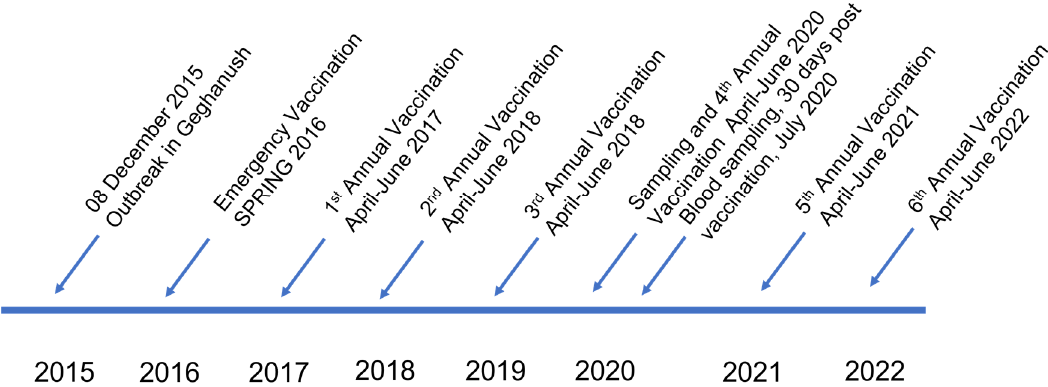
Figure 1. Outbreak on 8 December 2015 in the Syunik region. This was followed by an emergency vaccination campaign cattle during the spring of 2016 with a sheep pox virus vaccine strain. Vaccina- tion covered ~50% of all cattle at risk. Due to the epizootic situation in neighboring countries with LSD, scheduled preventive vaccinations are carried out annually in Armenia during the 2nd quarter of each year. Blood sampling in cattle was performed in 2020 for this